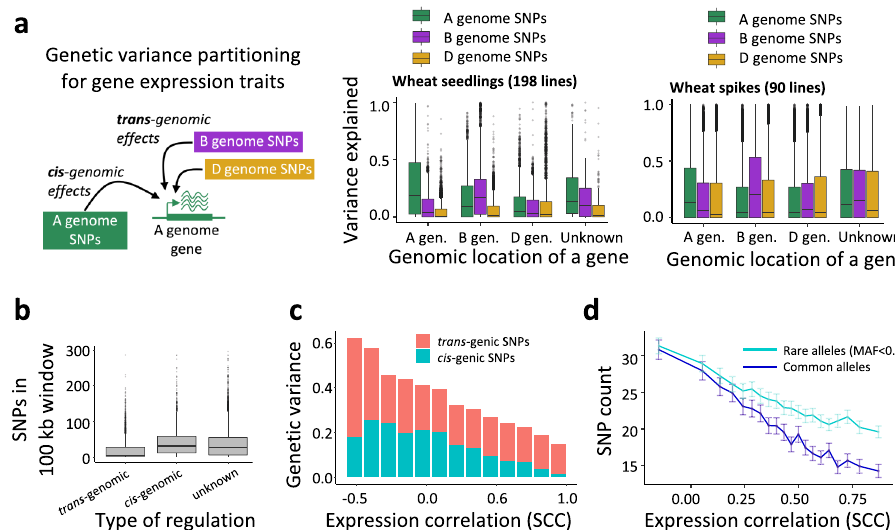
Fig. 2 Partitioning variance in homoeolog expression using SNPs from different parts of the wheat genomes. a An example of genetic variance partitioning for a gene located in the A genome using SNPs from the same genome ( cis -genomic SNPs) or other homoeologous genomes ( trans -genomic SNPs). As shown in the seedling panel, for genes in the A genome, variance explained by cis -genomic SNPs was 3.1 and 5.7 times higher than that explained by the B and D genomes ’ trans -genomic SNPs, respectively. Expression variance in the B genome was better explained by the B genome SNPs, which explained 1.3 and 3.4 times more variance than the SNPs from the A and D genomes, respectively. The variance explained by the cis -genomic SNPs from the D genome was comparable to that explained by the trans -genomic SNPs from the A and B genomes. Top 10,000 genes showing the highest expression variance were used in the analyses. b A 52.2% reduction in the mean SNP diversity (two-sided Mann – Whitney test W = 142,90,644, p -value < 2.2 × 10 − 16 ) was observed near 6173 genes with the expression variance mostly explained by trans -genomic SNPs, compared to 2852 genes with the expression variance explained predominantly by the cis -genomic SNPs. In ( a ) and ( b ), box shows the median and interquartile ranges (IQR). The end of the top line is the maximum or the third quartile (Q) + 1.5 × IQR. The end of the bottom line denotes either the minimum or the fi rst Q − 1.5 × IQR. The dots are more or less than Q ± 1.5 × IQR. c The relationship between the proportion of genetic variance explained by cis - and trans -genic SNPs calculated for individual homoeologs and the levels of expression correlation (SCC) between the pairs of homoeologs in the wheat panel. The mean of genetic variance was calculated for data binned based on the SCC values. d The counts of rare and common SNPs in the genic regions of the 21,809 pair-wise combinations of homoeologs (gene body ± 10 kb) showing different levels of expression correlation. The mean and standard error of SNP counts were calculated for data binned based on the ranked SCC values. Source data are provided as a Source Data fi